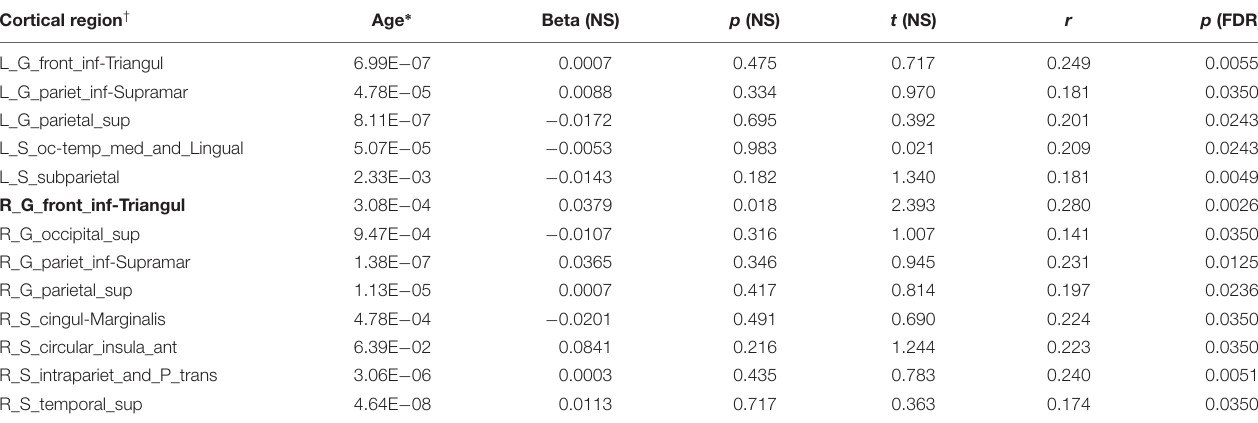
TABLE 6 | Dehydroepiandrosterone association with cortical